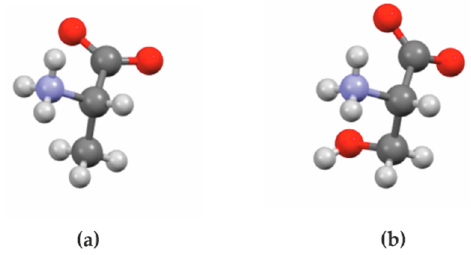
Figure 2. Molecules of alanine ( a ) and serine ( b ).